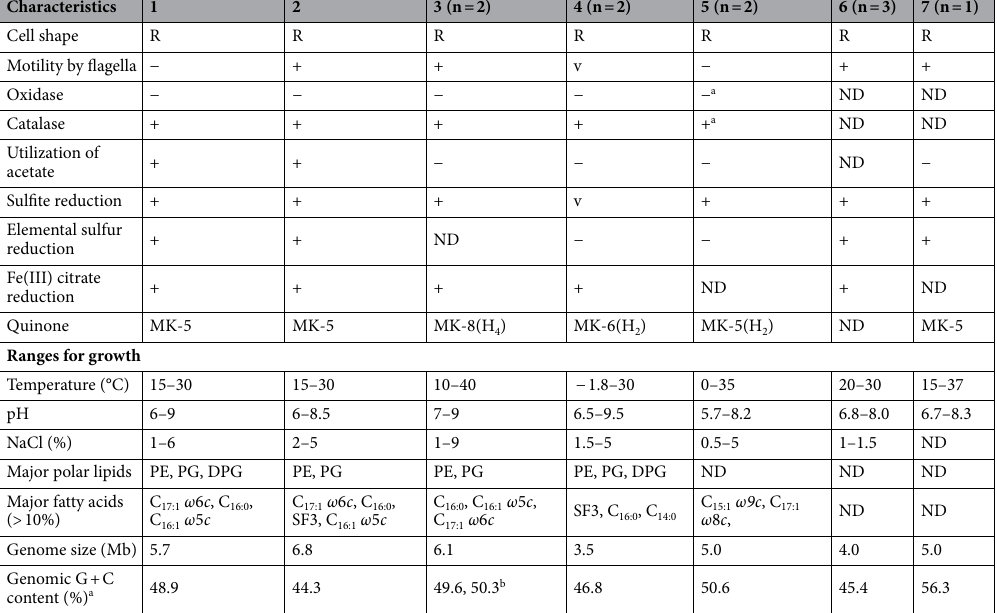
cola flagellatus sp. nov. are proposed, with IMCC35004 T and IMCC35005 T as the type strains, respectively. Description of Desulfosediminicola gen. nov..